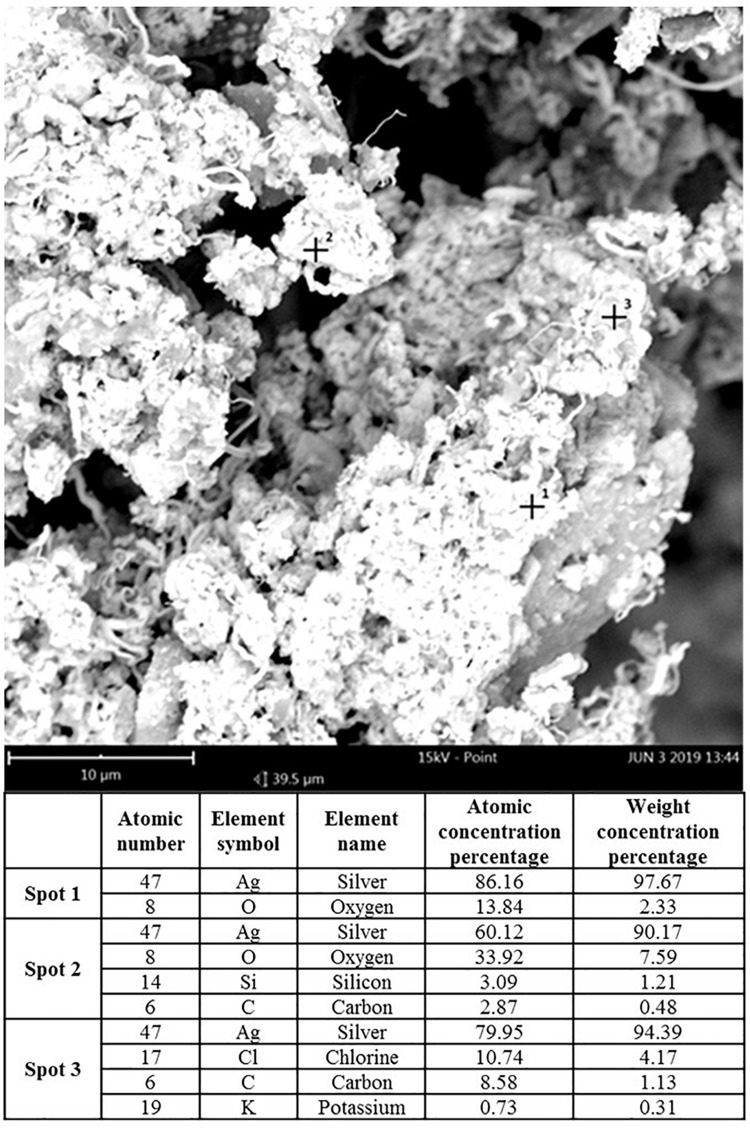
Scanning electron microscopy analysis of SUNCs. Magnification: 85,000× (scale bar: 10 μm–15 kV). Spots 1, 2, and 3 revealed different distribution of elements in the sample-different phases according to the SEM elemental analysis.